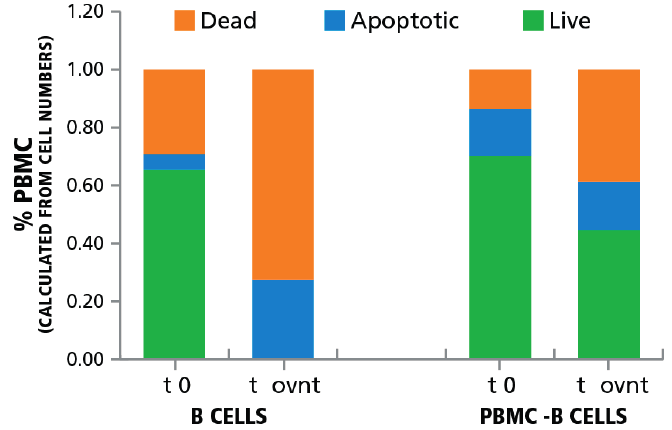
Figure 2. Induction of apoptosis in B cells using anti-CD20 coupled magnetic beads. B cells were isolated from PBMC using anti-CD20 coupled magnetic beads and were incubated overnight. The numbers of live, dead, and apoptotic cells was established right after separation (t 0) and after an overnight culture with anti-CD20 antibody (t ovnt). The percentage of live, dead, and apoptotic cells as detected by LDA staining are shown for the B cells and the PBMC population depleted of B cells (PBMC-B